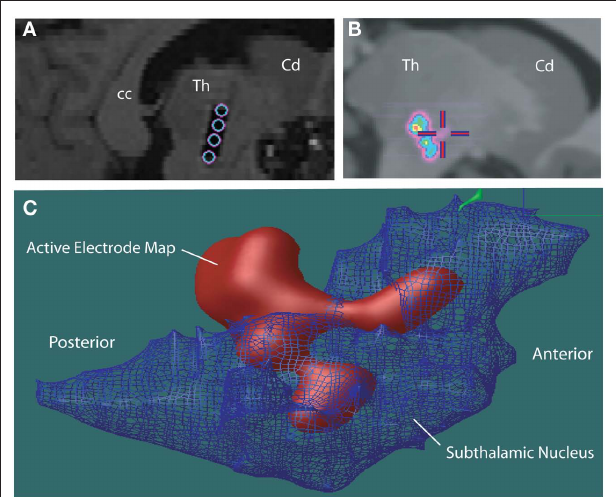
Figure 4 | (A) Post-operative sagittal T1-weighted MRI scan of a patient who underwent insertion of subthalamic stimulators for Parkinson’s disease. The hypointense signal artifact shows the four electrode contacts (Medtronic 3387) that traverse the subthalamic nucleus, identified during surgery using an array of five microelectrodes (“Ben’s Gun” array). The electrode contacts are within, and dorsal to the subthalamic nucleus. Abbreviations: cc, corpus callosum; Cd, caudate; Th, thalamus. (B) The automatic non-linear image matching and automatic labeling (ANIMAL) algorithm was used to integrate each patent’s MRI scan with the canonical high-resolution MRI (Colin27), resulting in a common space for evaluation of electrode positions from different patients. A probabilistic average map of active contacts of subthalamic stimulators associated with the best outcome for motor symptoms of the contralateral side is shown. (C) The voxel-labeled 3D atlas was integrated with the probabilistic volume map of the most effective active electrode contacts in patients with Parkinson’s disease with subthalamic stimulator implants. The subthalamic nucleus is represented as a net. A 90% probability map of most effective electrode positions shows they are localized in the dorsolateral subthalamic nucleus, and areas dorsal and posterior to the subthalamic nucleus, including the zona incerta, Forel’s fields, and